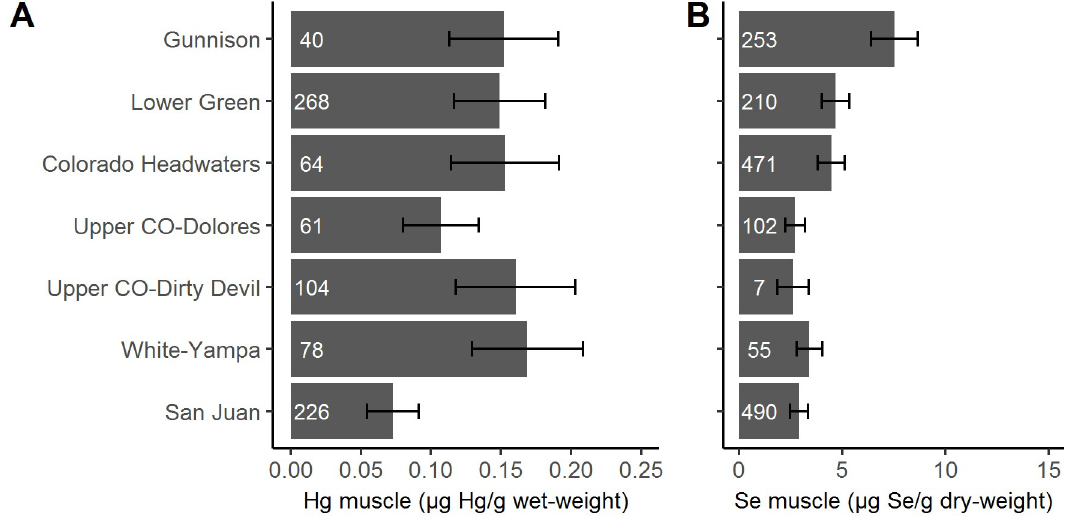
Fig 3. Least-squares means for total mercury (THg, size standardized, A) and selenium (Se, not size standardized, B) concentrations in muscle tissue from fish assemblages across tributaries of the Upper Colorado River Basin. Bars are least- squares means controlling for the effects of site, species, year, and size where appropriate. Error bars represent one standard error. White numbers indicate sample size.